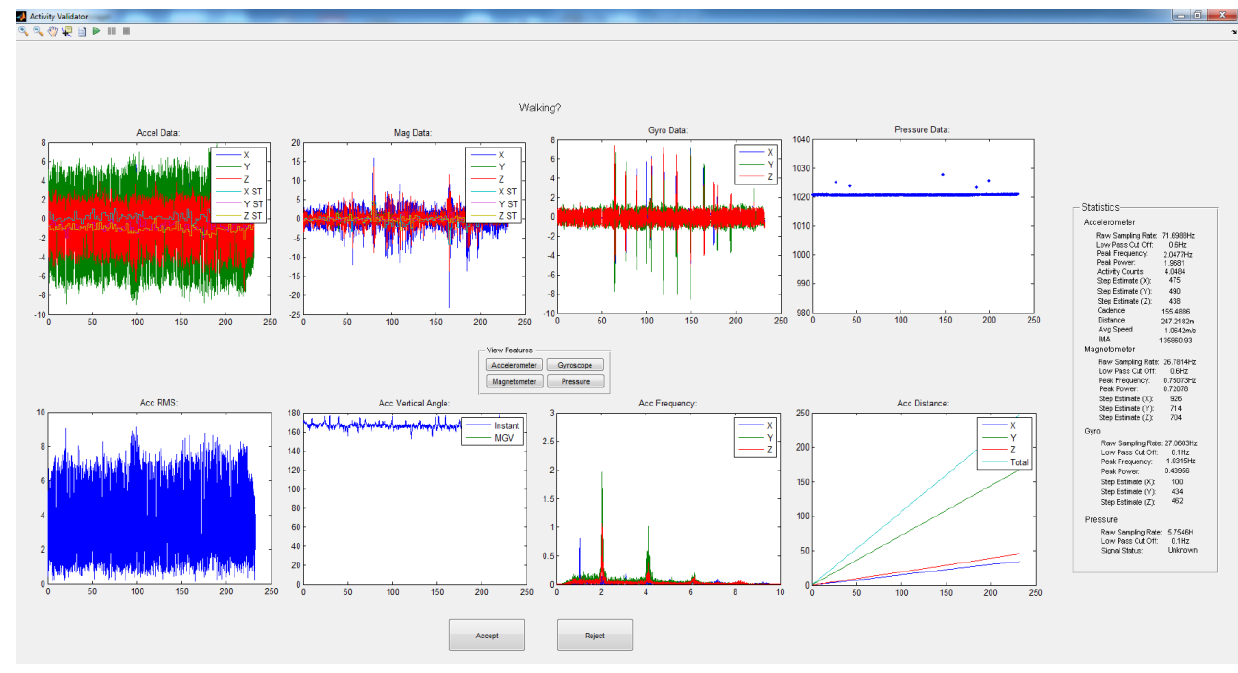
Figure 3. LightSabre application.